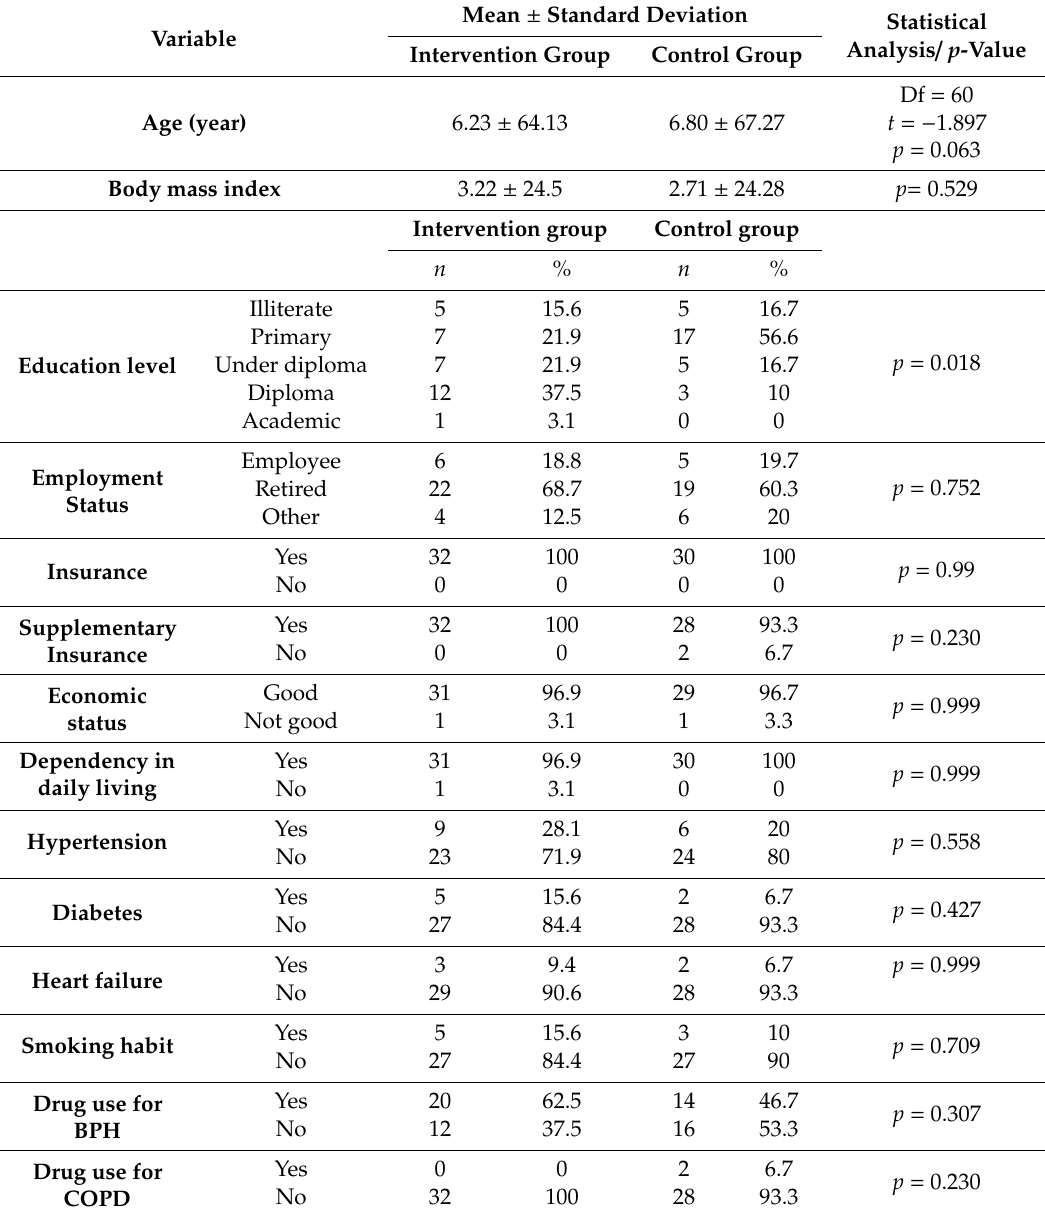
Table 2. Demographic characteristics of the older patients in the groups. Mean ± Standard Deviation Variable